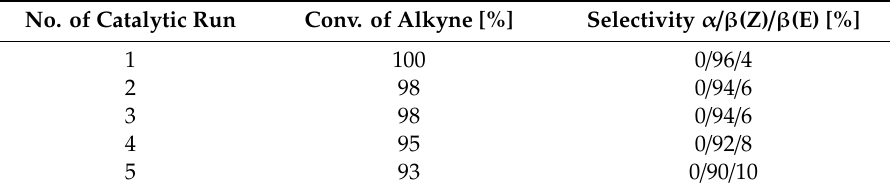
Table 4. The conversion and selectivity for hydrosilylation of 1-octyne with HMTS in subsequent catalytic runs catalyzed by the same portion of the catalyst 1 isolated from the post-reaction mixture by